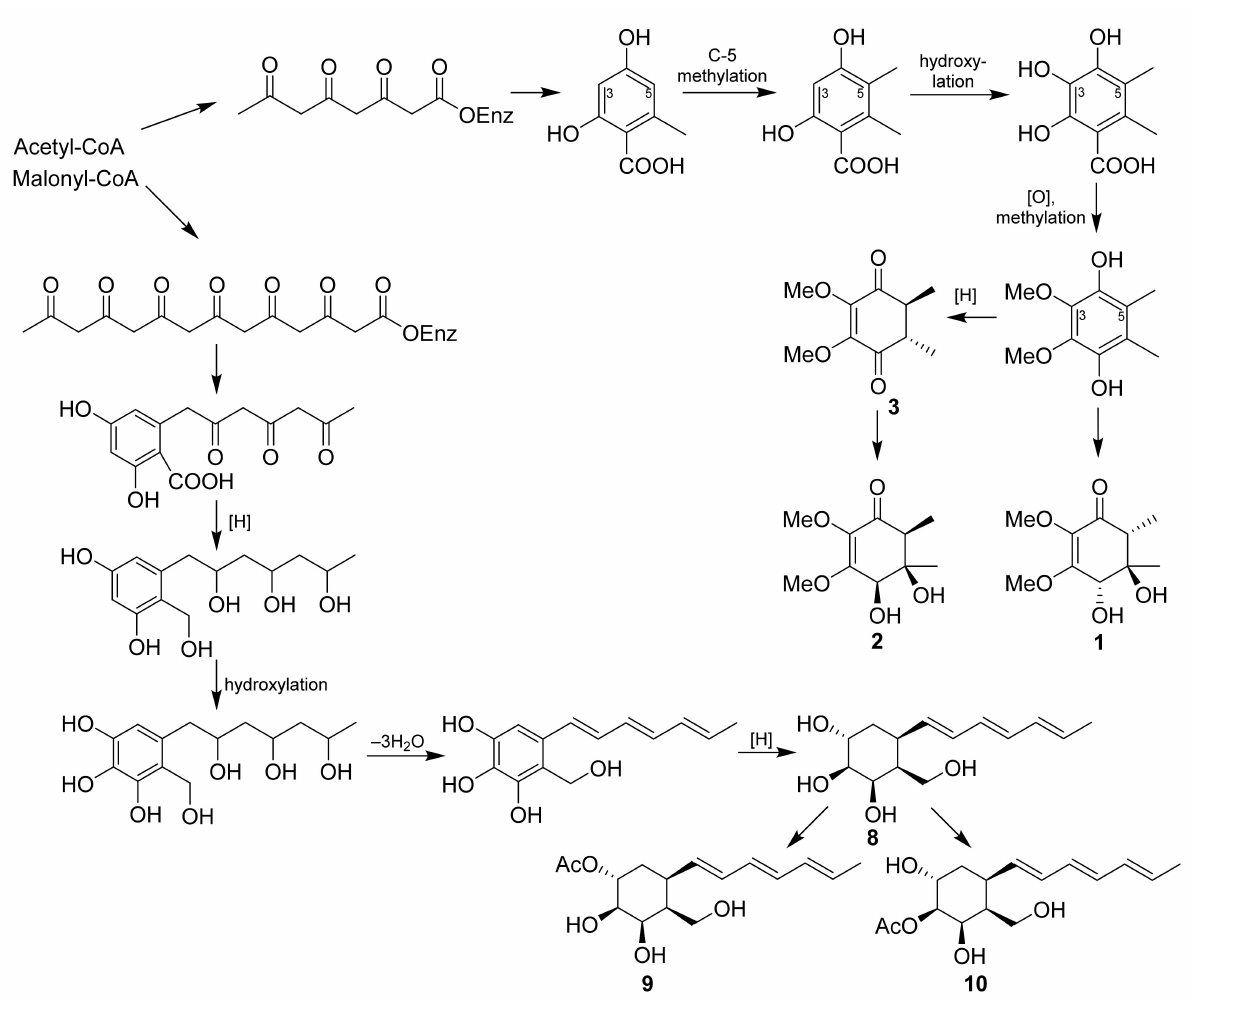
Figure 7. Proposal biosynthetic pathway for compounds 1 – 3 and 8 – 10